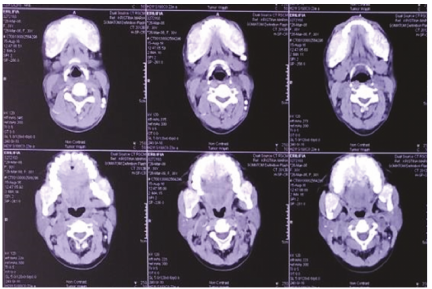
Figure 7: Case 2. Head CT scan showing di ff used hyperostosis with multiple lytic lesion among the bones of maxilla, mandible, and the